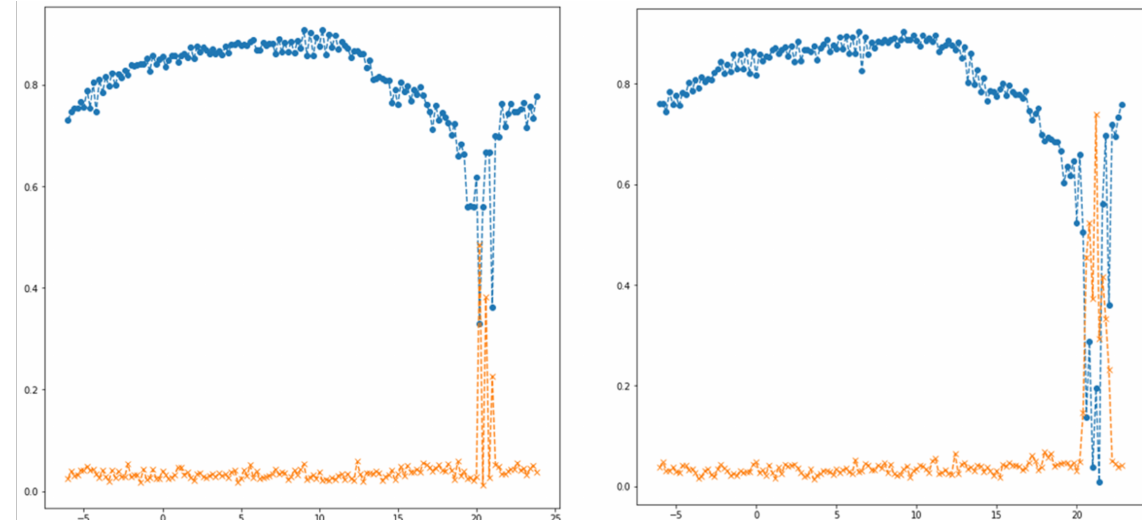
Figure 18. Simulated configuration I: neighboring blocks with parallel, aligned rows and gap dis- tances (headland widths) equal to 5 m and 6 m for the left and right figures, respectively. The valid point ratios (blue points) and the deviation of yaw angles (orange points) are shown as functions of the x-coordinate of the robot. As the robot approaches the end of the row (x gets closer to 25 m), more and more points from the neighboring block enter the FOV of the camera. The row-end detec- tion algorithm could barely work (it failed) when the headland width was 5 m ( left ) shows minor deviations in both metrics). Still, it was successful when the distance was 6 m ( right ) shows drastic changes in valid point ratios and yaw